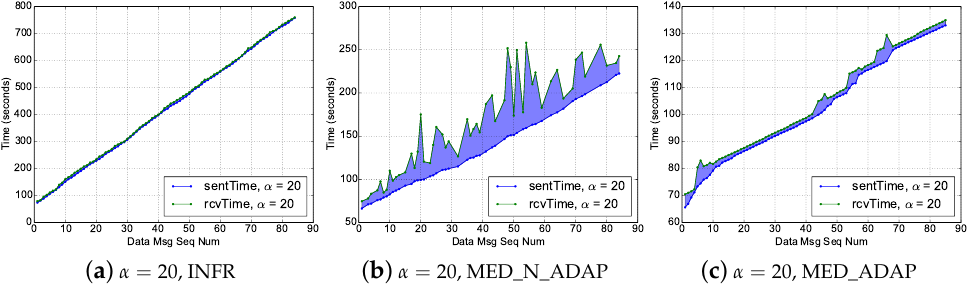
Figure 9. Time of sending and receiving of packets of a sample